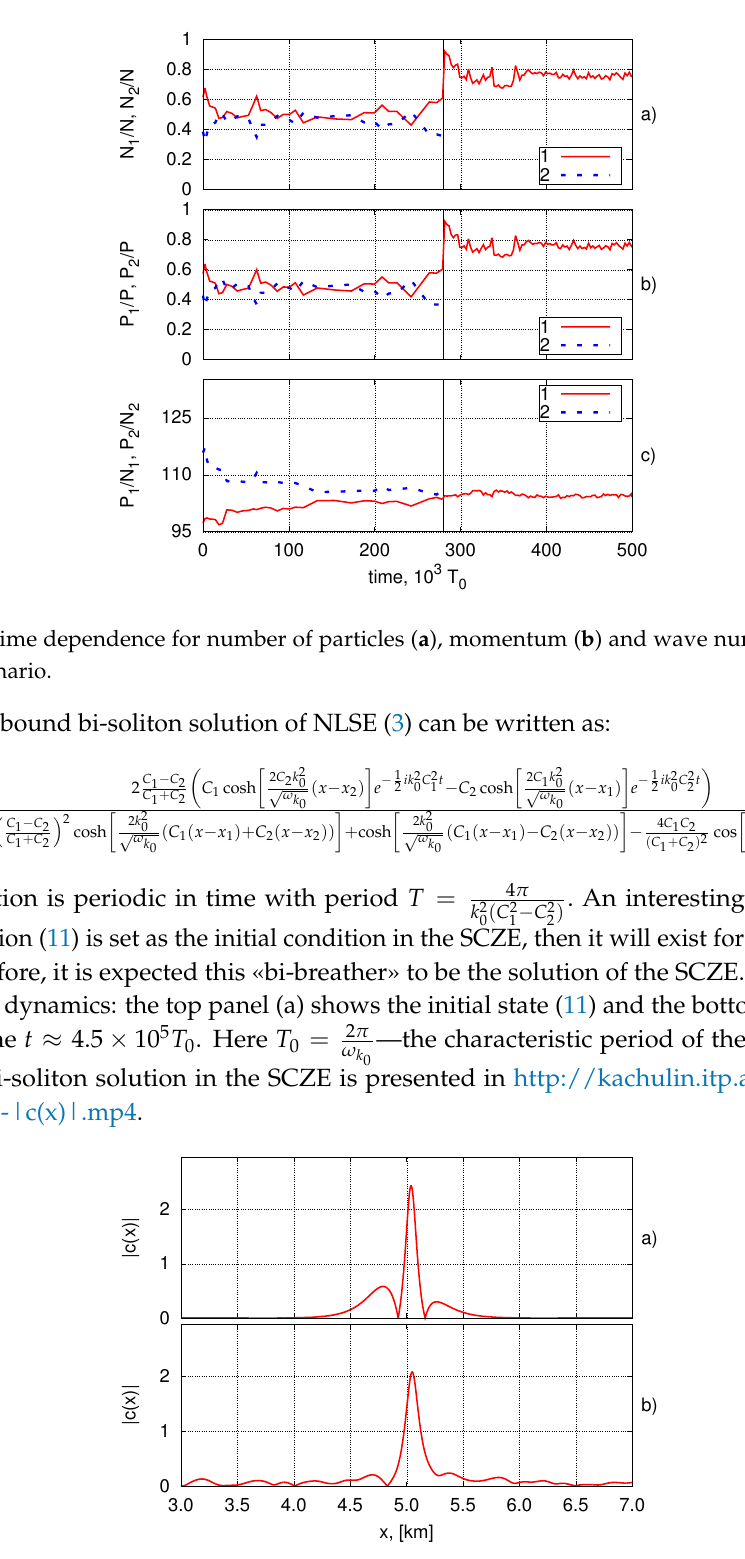
Figure 4. Bi-breather evolution in the SCZE. Initial state (t = 0) is shown on the top panel ( a ). State at time t ≈ 4.5 × 10 5 T 0 is shown on the bottom panel ( b